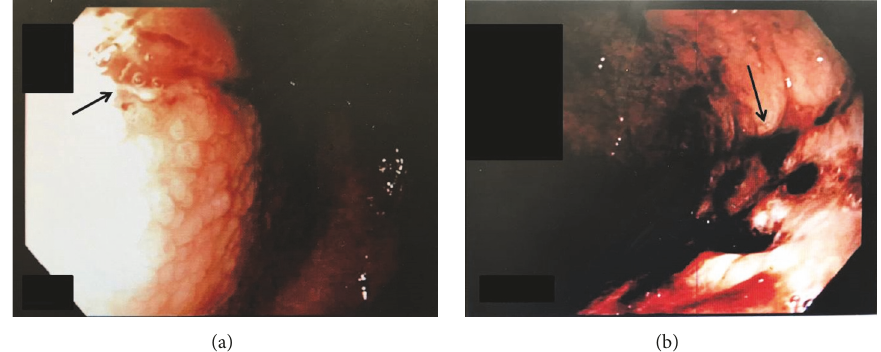
Figure 1: Endoscopic photos of the body of the stomach show diffusely nodular mucosa (a) with deep linear ulcers (arrows) and severe inflammation and hemorrhage (b).